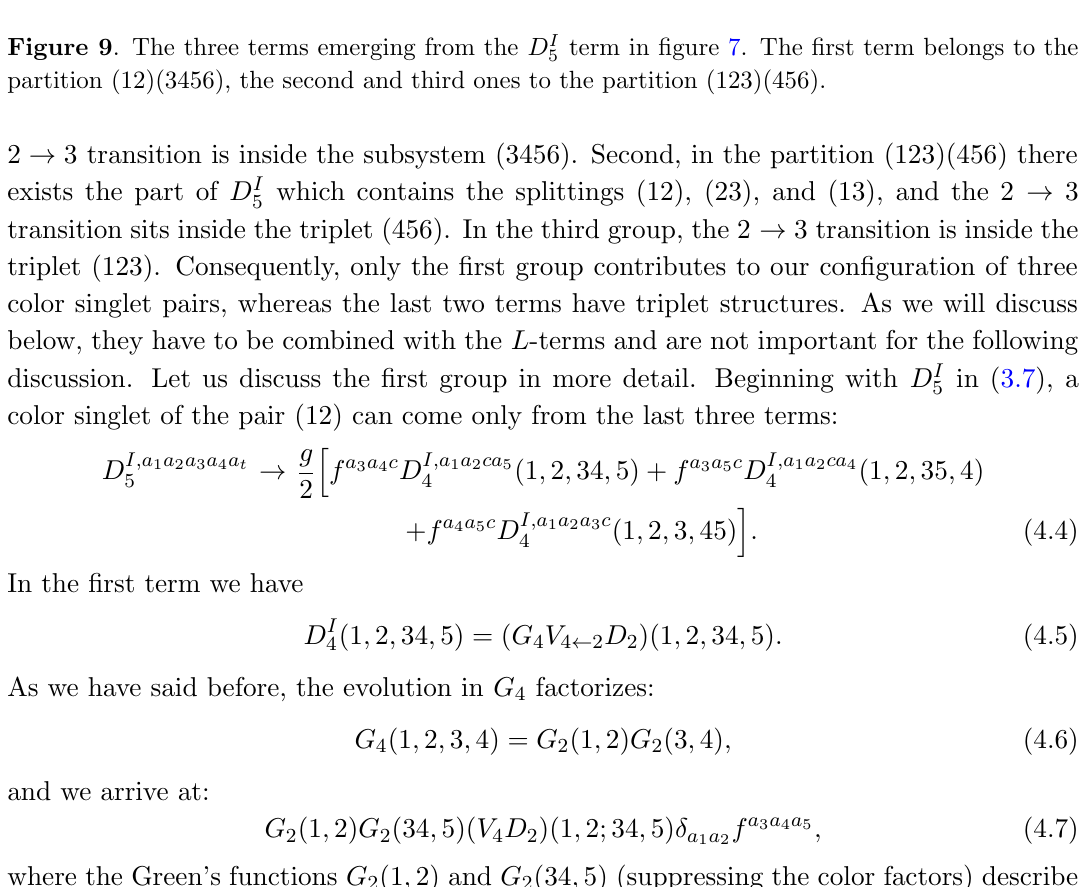
term in (cid:12)gure 7. The (cid:12)rst term belongs to the 5